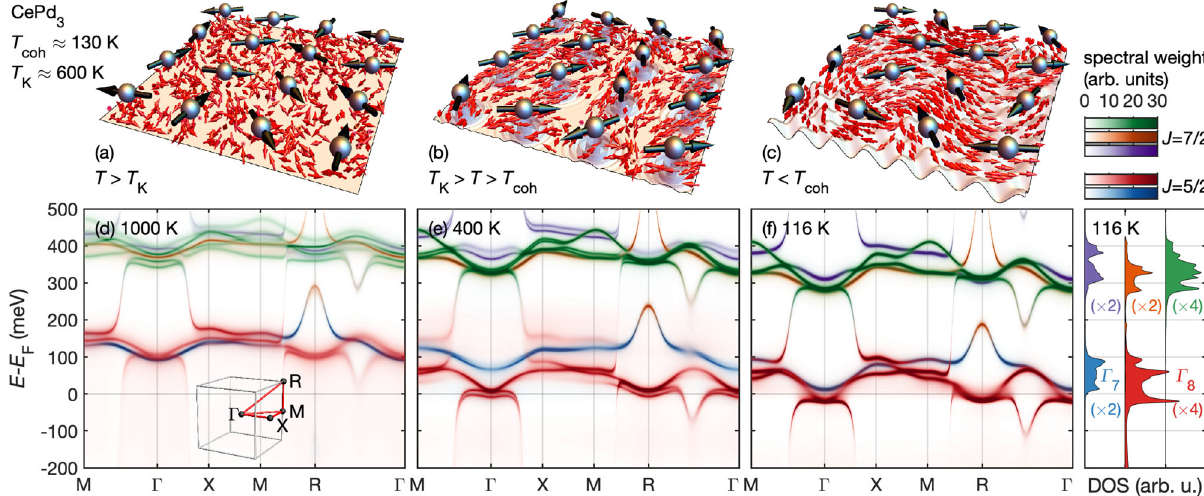
Fig. 1 | Emergence of a coherent Kondo lattice state as a function of tempera- local f -electronmomentsareuncorrelated.Thecorrespondingelectronicstructure ture in CePd 3 . a – c Real-space impressions of the increasingly coherent screening only shows weak hybridization with the incoherent f -states. b , e For T < T K , local f -electron magnetic moments effectively couple to the surrounding conduction of Ce moments (black arrows) across the temperature scales T K and T coh . Spins of itinerant electrons are represented by red arrows (see text for details). electrons, forming virtual-bound states in the vicinity of the Fermi energy E F d – f Electronicspectralfunction A ( k , ω )ofCePd 3 obtainedfromthecombinationof (suggestedasripplesin b ).The f spectralweightclosetotheFermisurfaceremains densityfunctionalanddynamicalmean fi eldtheory(DFT+DMFT)at1000K,400K, predominantly incoherent. c , f Below the coherence temperature T coh ≈ 130K, the f -statesarecoherentlyincorporated(suggestedbythelattice-coherentmodulation and 116K. The fourteen 4 f orbitals of cerium form seven Kramers doublets, sepa- inPanel c )intotheunderlyingbandstructureasdispersive,albeitheavy,electronic rated intoa J =5/2sextupletanda J =7/2octupletby E SO ≈ 280meV.Acubiccrystal ≈ 10meVsplittingbetweena J =5/2 Γ fi eld(CF)furtherinducesa E quasiparticles. The right panel showsthe density ofstates (DOS)summed over the SO 7 doublet(blue) and the Γ 8 quartet (red). The J =7/2 states are split into two doublets (purple and displayed high-symmetry directions, projected onto the different CF orange) and one quartet (green). a , d Above the Kondo temperature, T K ≈ 600K,